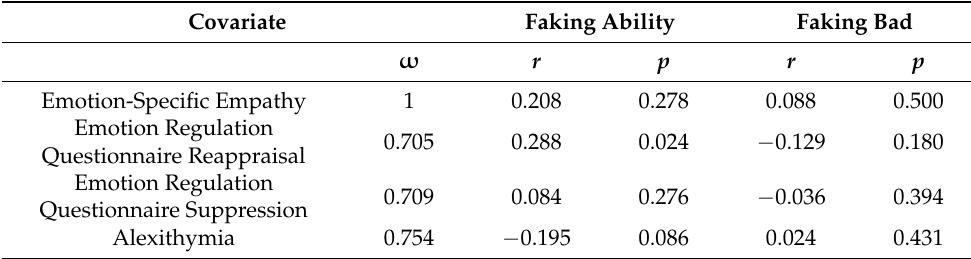
Table A2. Correlations with typical socio-emotional traits.